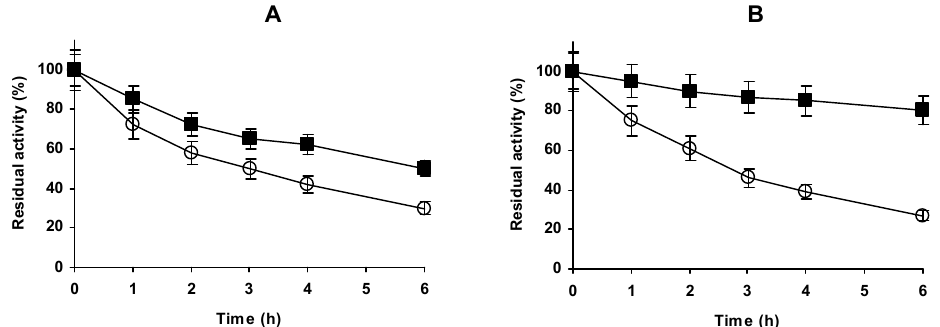
Figure 7. Effect of glutaraldehyde treatment on the stability of immobilized and aminated under different conditions. Glx-AL-EDA was modified at pH 7 with glutaraldehyde and then incubated at pH 9 for 3 h before reduction. Inactivation courses were studied at pH 4 and 44 °C ( A ) and at pH 9 and 58 °C ( B ) Open circles: Glx-AL-EDA, Solid Squares: Glx-AL-EDA-GLU.